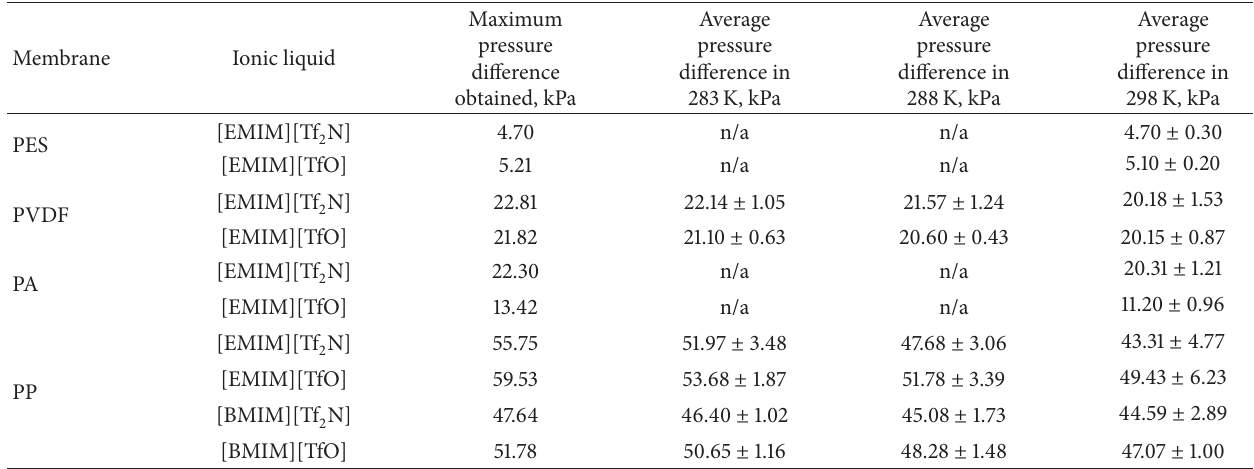
Table 5: Mechanical stability of